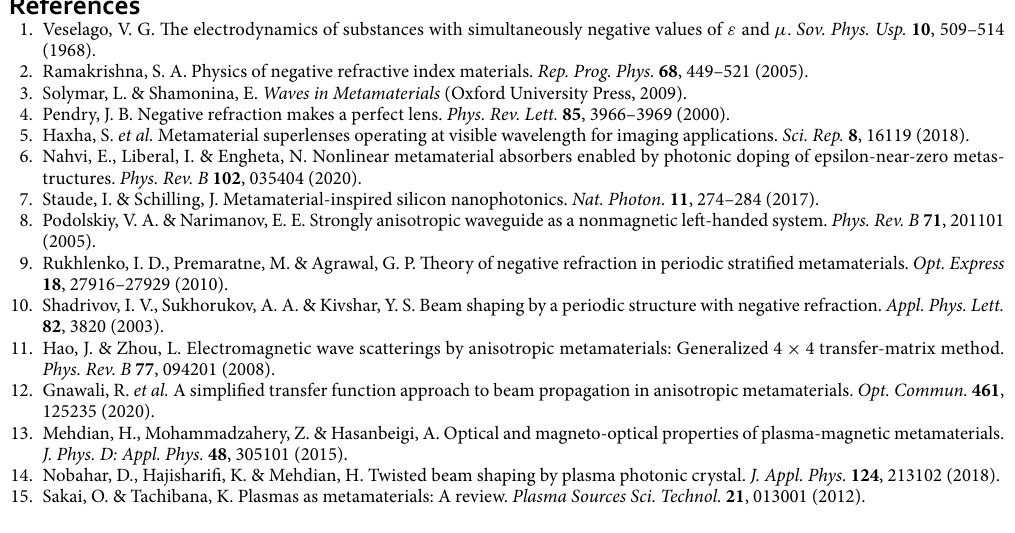
Figure 7. OAM spectrums of transmitted VB for H 0 n e 3 10 12 cm = ×